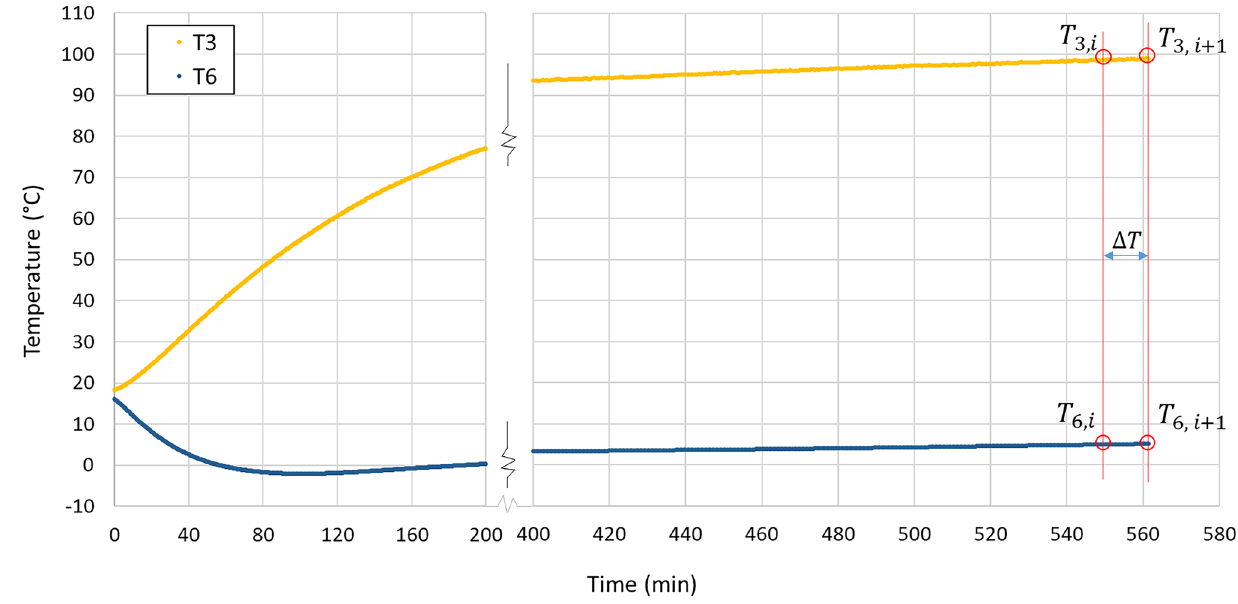
Fig. 4 Stability condition